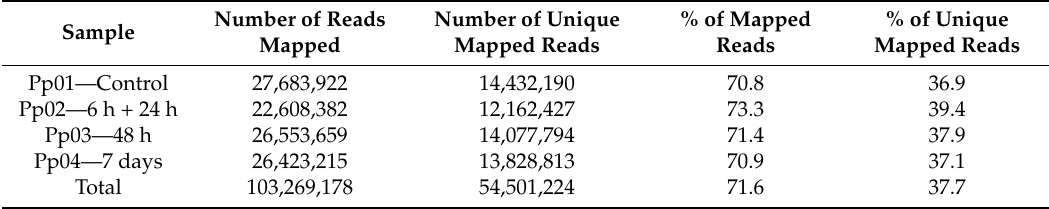
Table 2. Number of mapped reads, unique mapped reads and their percentages for each library.